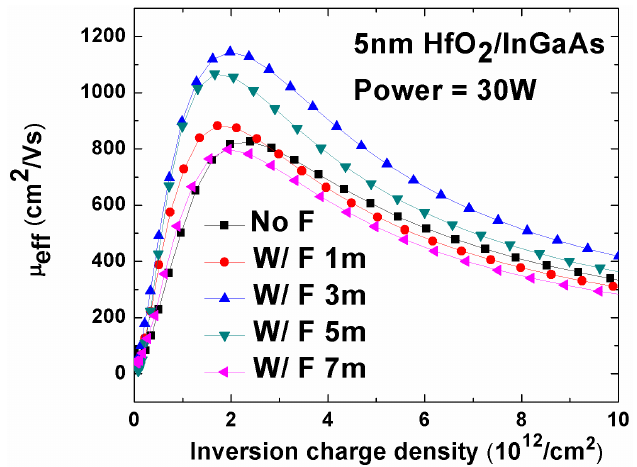
Figure 10. Effective channel mobility versus inversion charge density as a function of CF /O plasma treatment time. RF power: 30 4 2